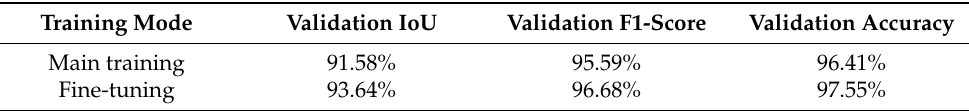
Table 3. Quantitative validation results after the main training phase and after